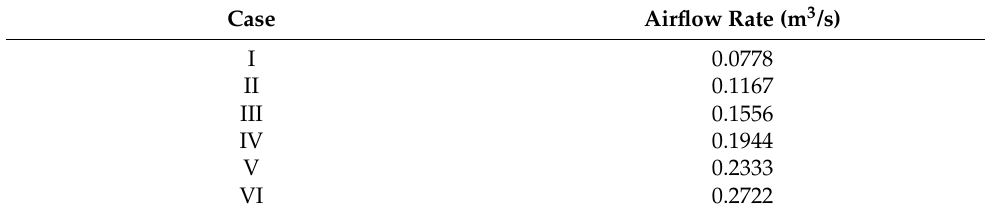
Table 1. Airflow rate case studies.